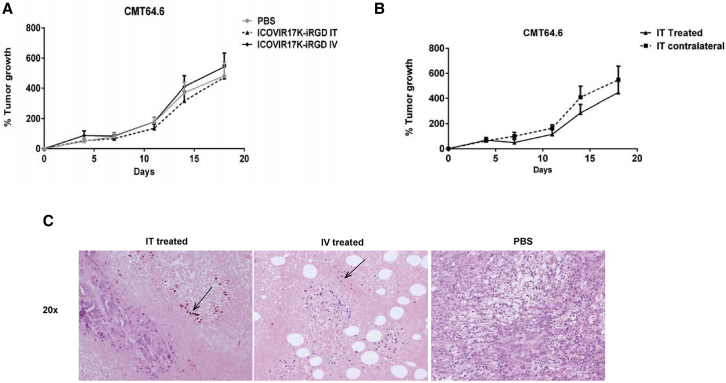
Anti-tumor Efficacy of Systemic or i.t. Administration of ICOVIR17K-iRGD in Immunodeficient MiceAthymic nude mice bearing CMT64.6 murine lung carcinoma subcutaneous tumors were treated via an i.v. or i.t. single dose of PBS or 3 × 1010/mouse of ICOVIR17K-iRGD. (A) Percentage of tumor growth at the indicated days is plotted (n = 11–12). (B) Comparison of injected and non-injected contralateral tumors of the i.t. mice group. Percentage of tumor growth (mean ± SEM) at the indicated days is plotted (n = 5–6). (C) Immunohistochemical staining of E1A of a representative tumor treated i.t. The arrow points to positive virus E1A staining.